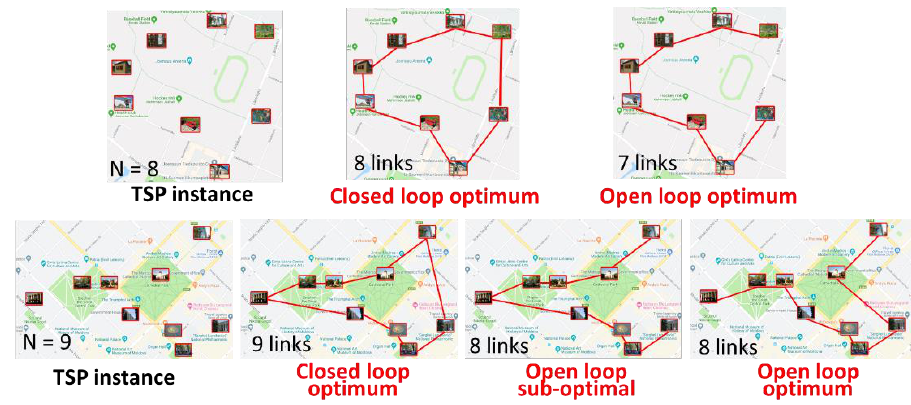
Figure 1. Difference between open- and closed-loop traveling salesman problem (TSP).